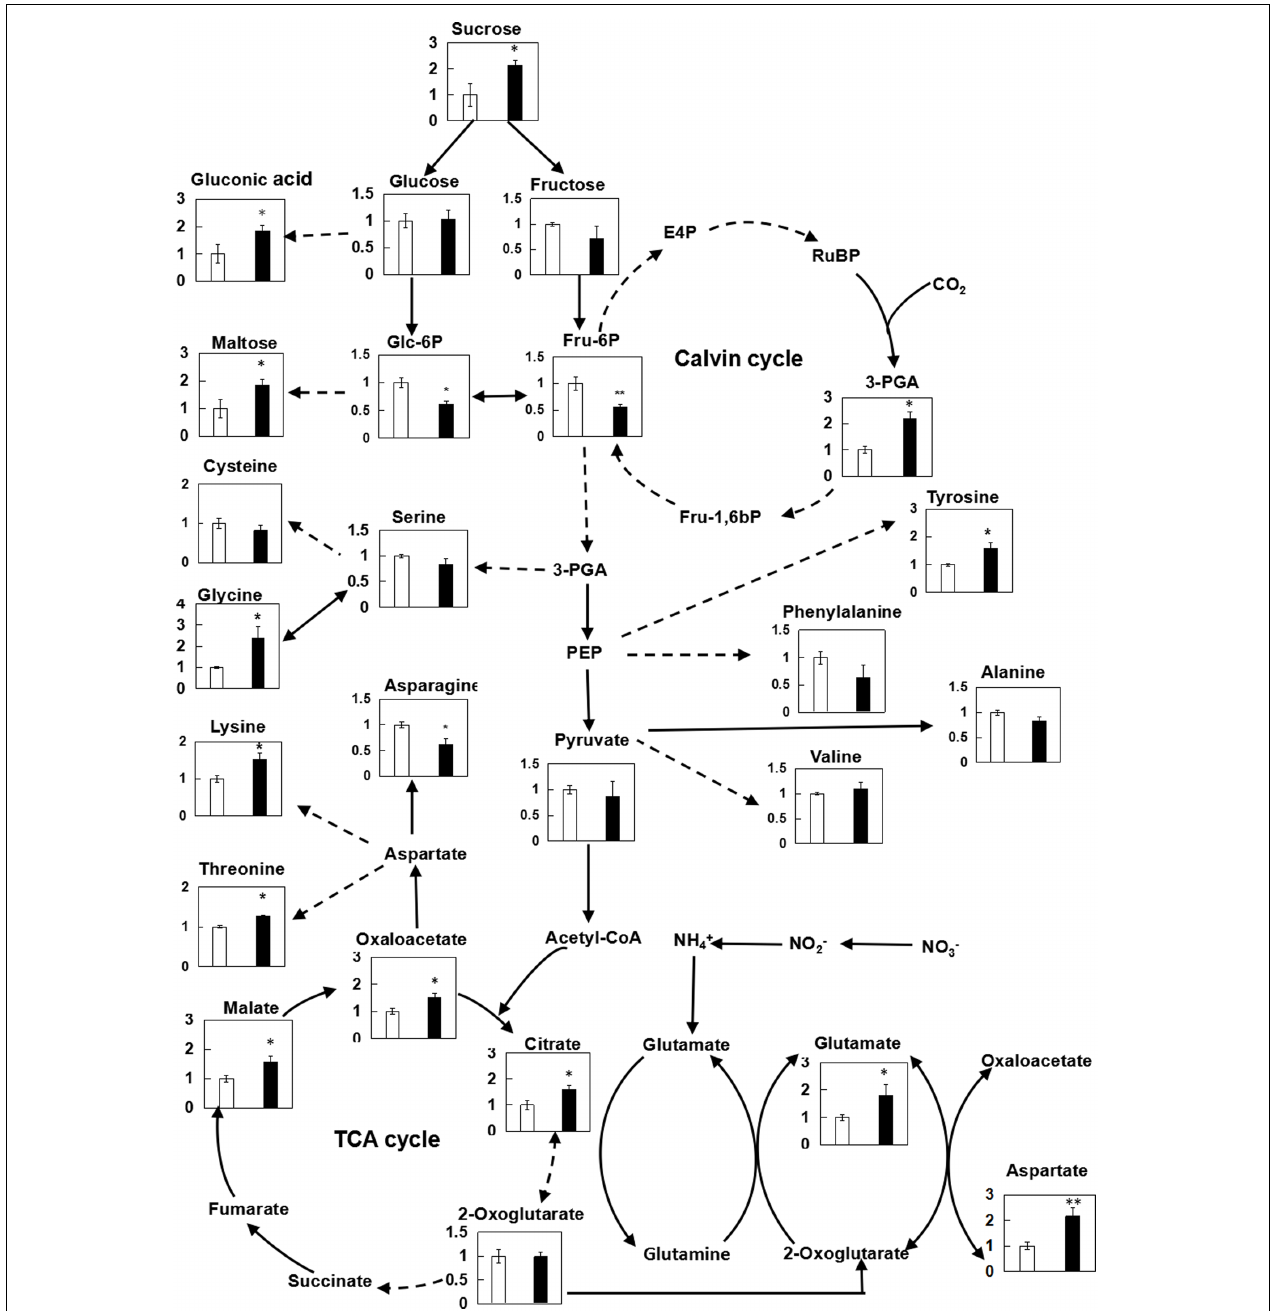
FIGURE 3 | Relative contents of metabolites in leaves of wheat seedlings treated with (GlcN) 7 determined by GC-TOF-MS. The relative metabolite levels are normalized to internal standard (ribitol) and fresh weight (FW) of samples, and then expressed as the ratio between values obtained from CK and (GlcN) 7 -treated groups, and ultimately displayed on a primary metabolite map. Continuous arrows represent a single enzymatic step while broken arrows represent pathways involving more than one reaction. The values are mean ± SE calculated from six independent biological replicates. Significant differences from the control are shown ( ∗ P < 0.05, ∗∗ P < 0.01; t